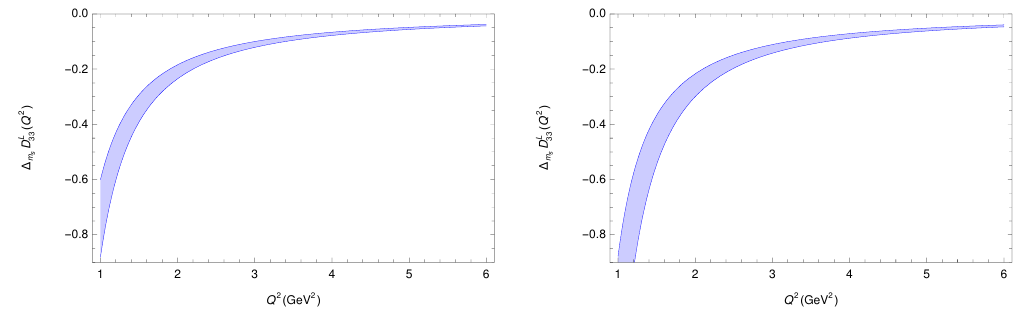
Figure 3 . Q 2 dependence of ∆ m